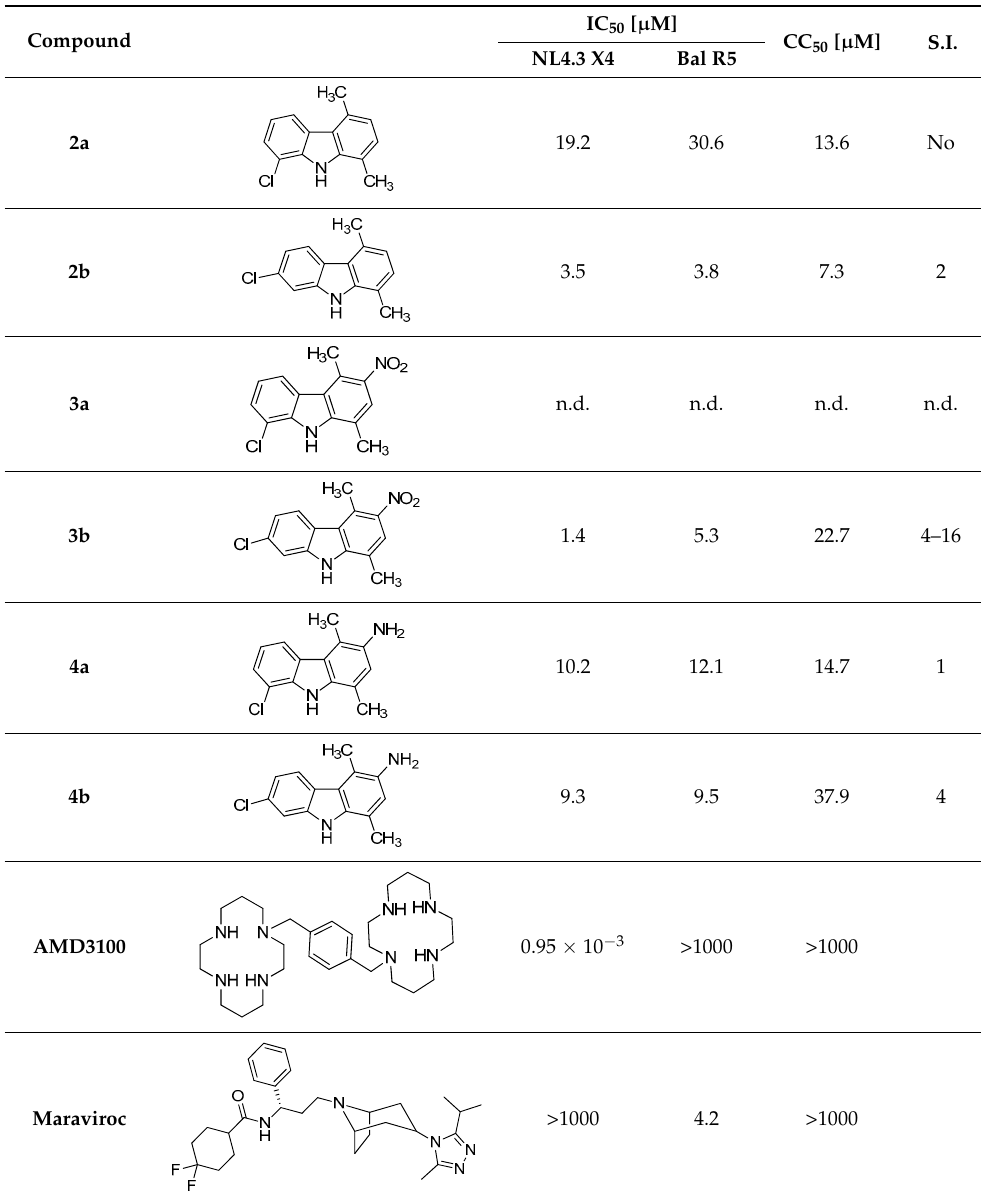
Table 1: Anti-HIV-1 activity profile of compounds evaluated in TZM-bl cells.